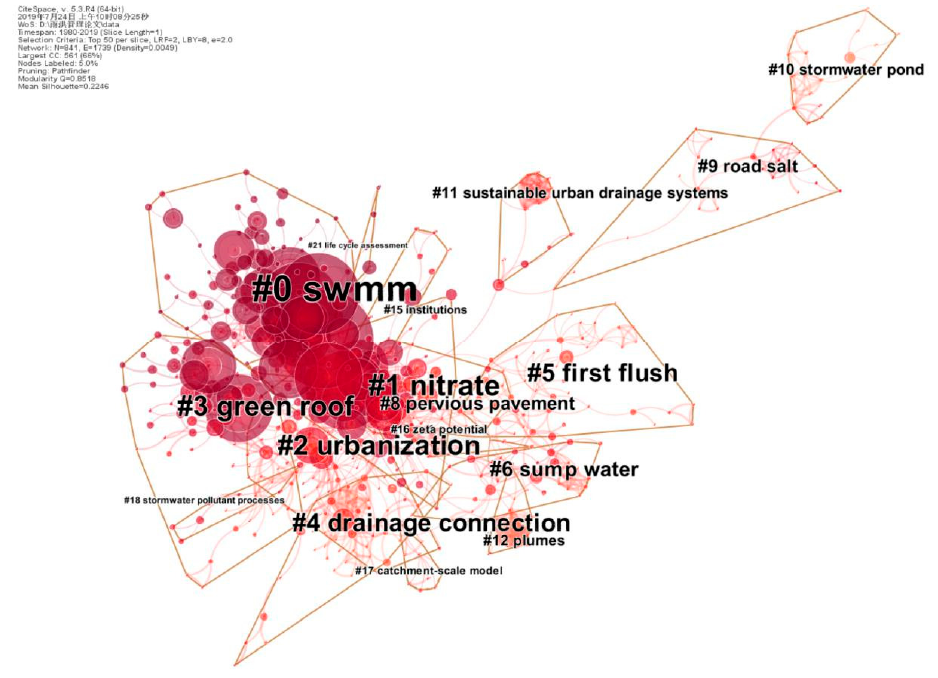
Figure 4. Clustering analysis of articles.